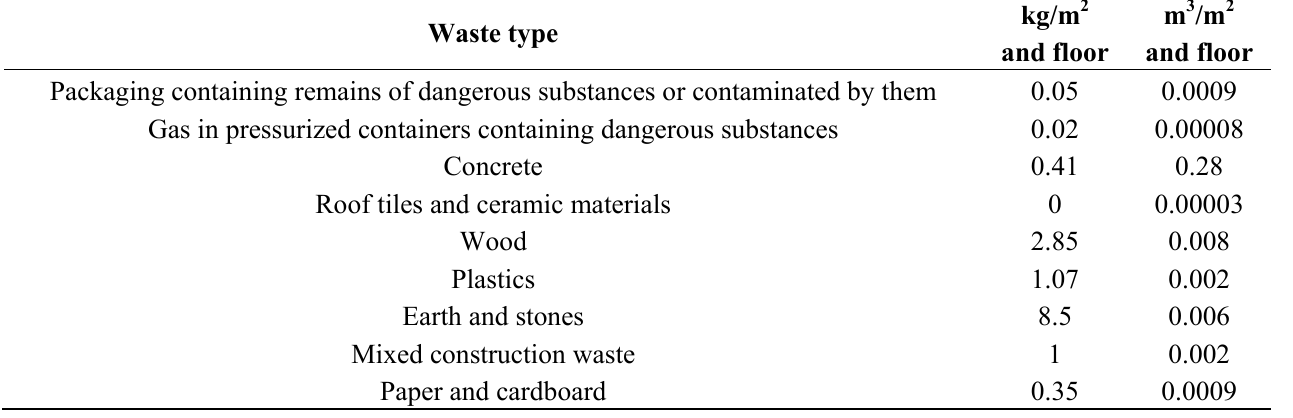
Table 2. Ratios of amounts of construction site waste